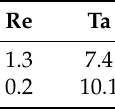
Table 1. Chemical compositions of CMSX-4 substrate and γ’-phase layer (wt %).